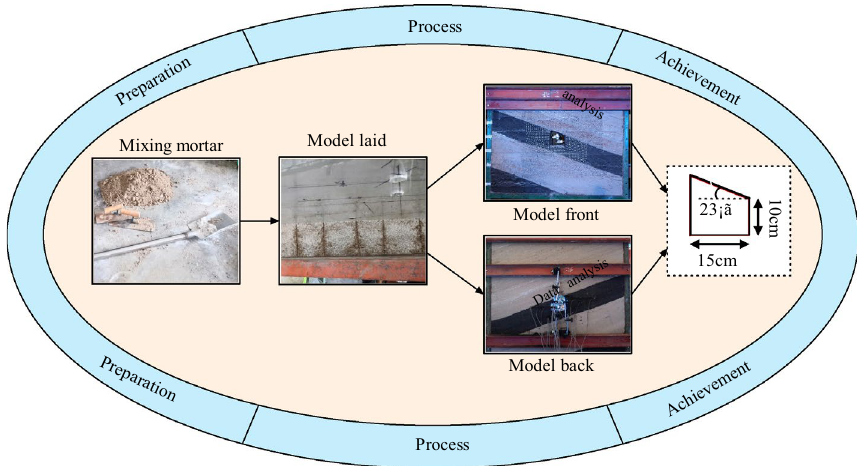
Figure 23. Physical simulation test system.